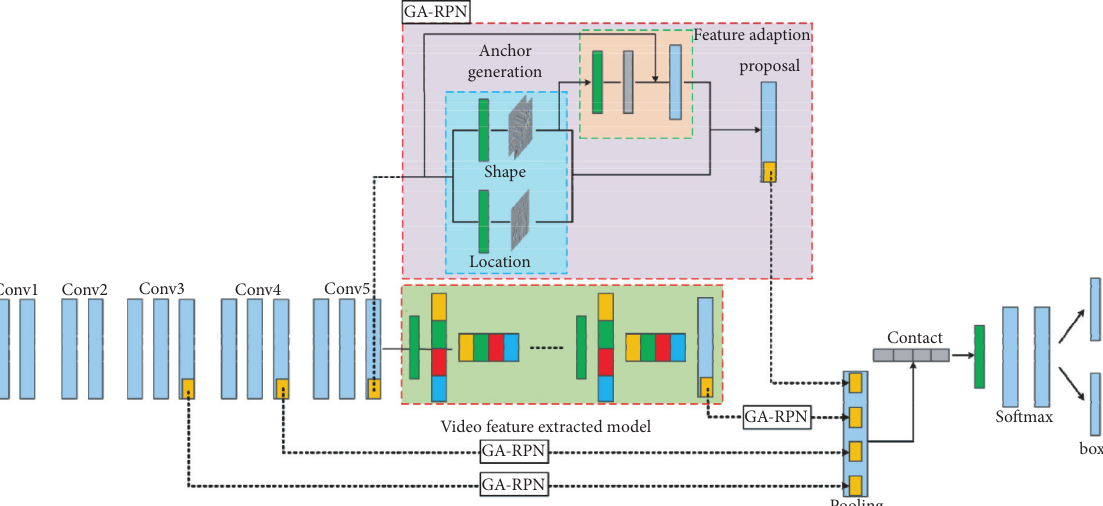
Figure 1: Adaptive Gaussian incremental expectation algorithm